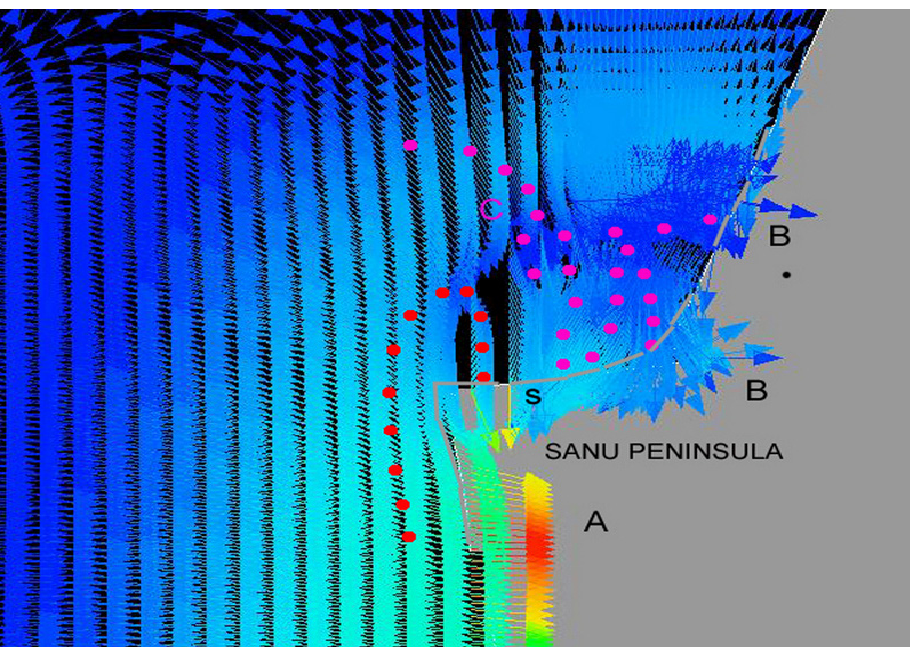
Figure 31. Dot trajectories of the sediment transport paths from the coastal valleys south of the Sanu Peninsula. North of the Sanu peninsula, extreme ocean turbulence and induced rotational flow in the upper concave shoreline region enhance particle settling, resulting in the shoreline shape modification.